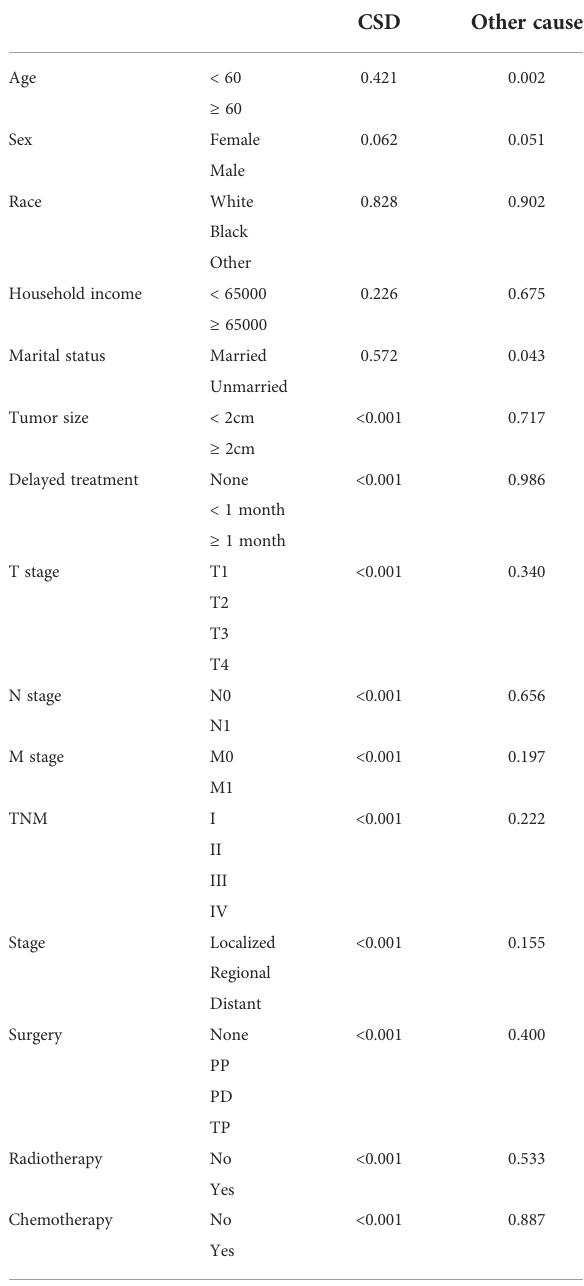
TABLE 2 Univariate competitive risk analysis of G1 pNETs